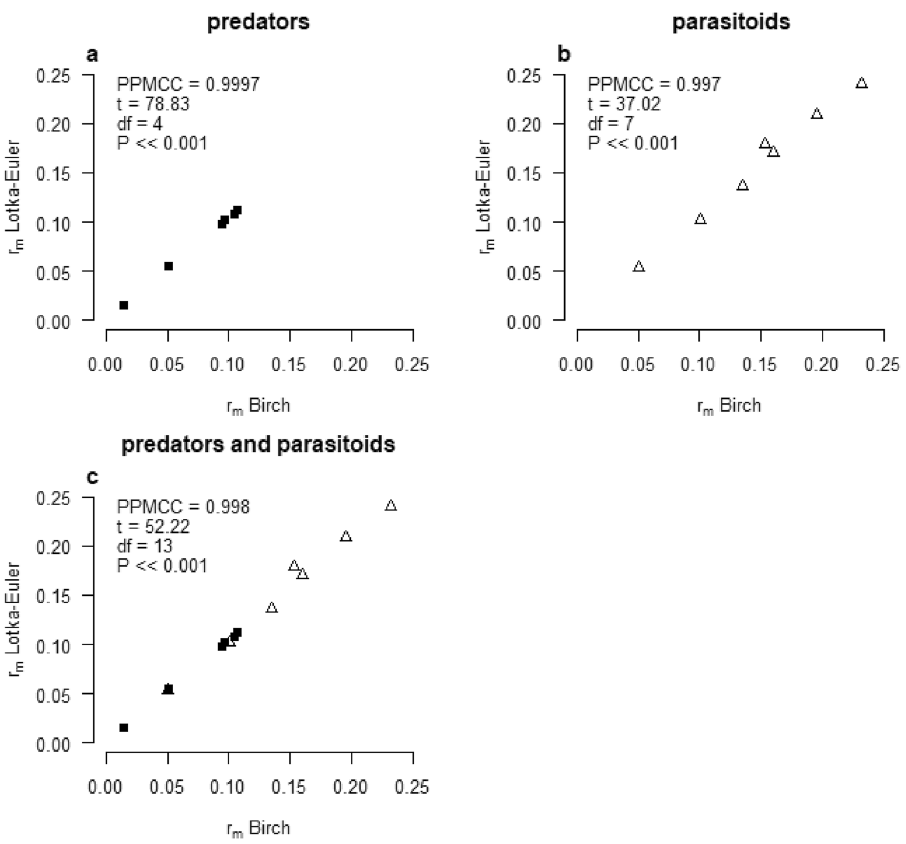
Figure 1. Correlation between values of r m calculated by the Birch (x-axis) and the Lotka-Euler (y-axis) approach for predators ( a ), parasitoids ( b ) and predators + parasitoids ( c ).